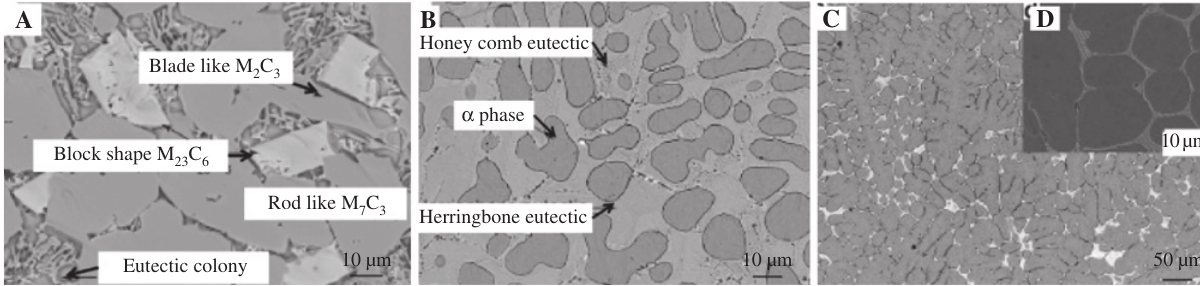
Figure 21: Microstructure of the (A) inner, (B) intermediate, and (C) outer layers of the coating. (D) Outer layer microstructure at high magni- fication [73].